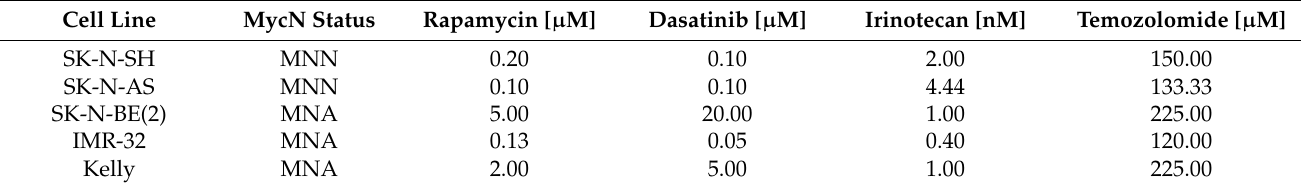
Table 2. Drug concentration applied for the R+D ‘pre-treatment’ and I+T ‘chemo-treatment’ in the multimodal in vitro RIST treatment protocol.